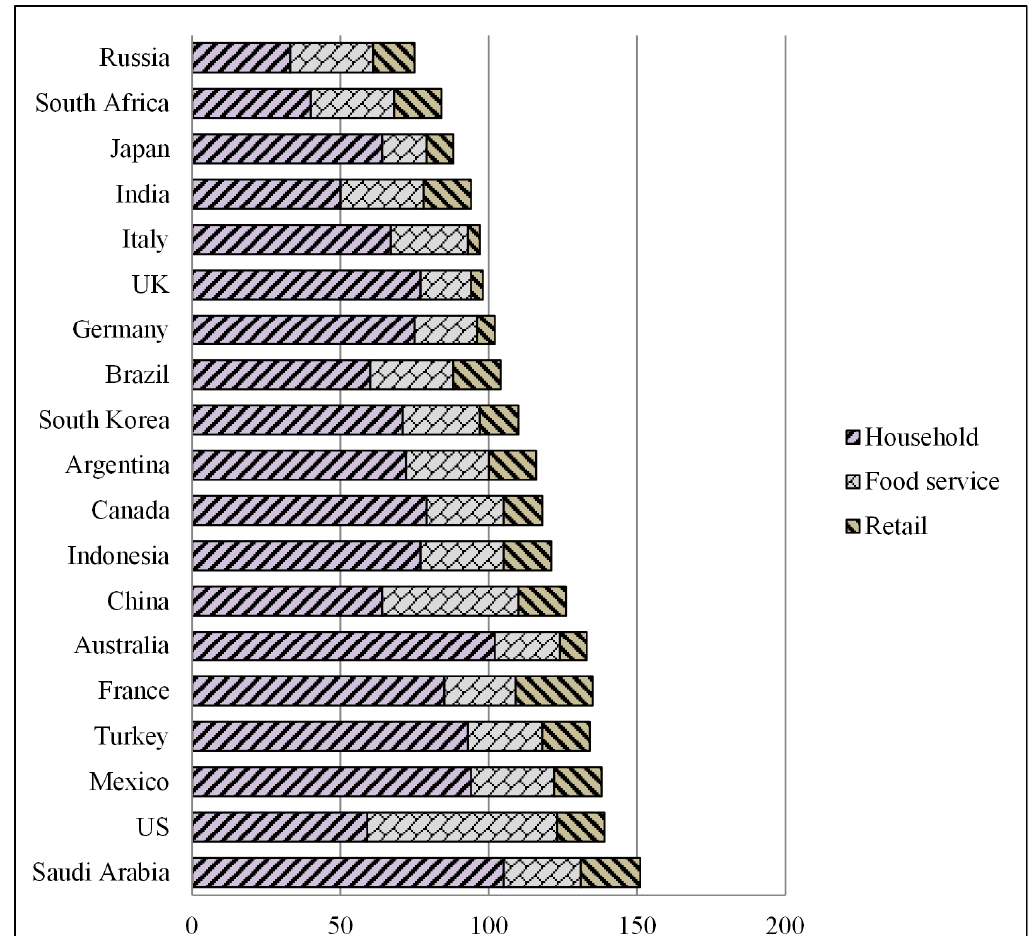
Figure 4. Food waste index flowchart (kg/head/year) 2021 [20].